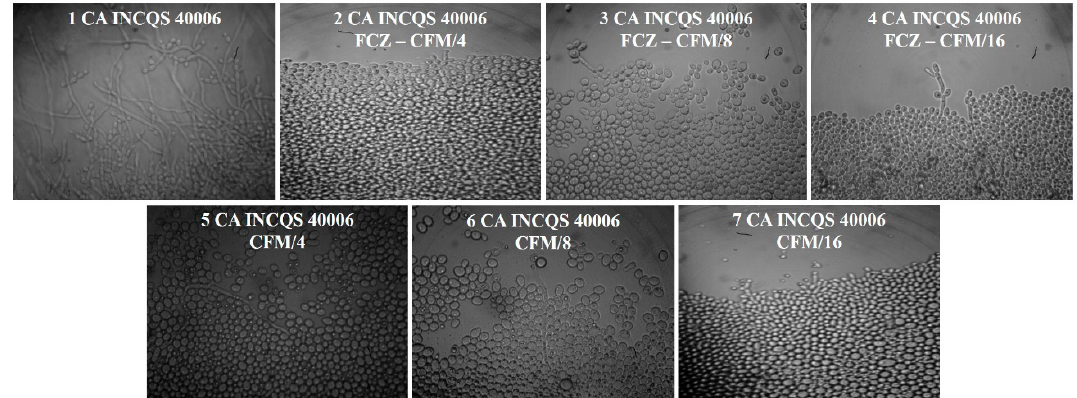
Figure 3. Effects of essential oil of Piper caldense on the dimorphism of Candida albicans INCQS 40006. Slide (S1): Growth control; S2–4: Effect of fluconazole at concentrations 4096 μ g/mL (S2), 2048 μ g/mL (S3), 1024 μ g/mL (S4). S5–7: Effect of essential oil at concentrations of 4096 μ g/mL (S5), 2048 μ g/mL (S6), 1024 μ g/mL (S7). Display 400× increased.